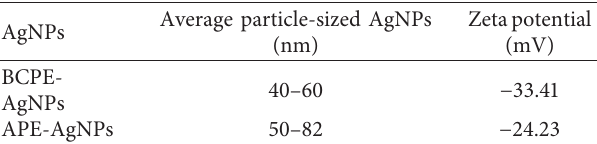
Figure 3: UV-Vis absorption spectrum of BCPE-AgNPs (1) and APE-AgNPs (2) after 30min of reaction displaying the charac- teristic surface plasmon resonance band at 430nm. Table 3: Characteristics of AgNPs synthesized using the BCPE and